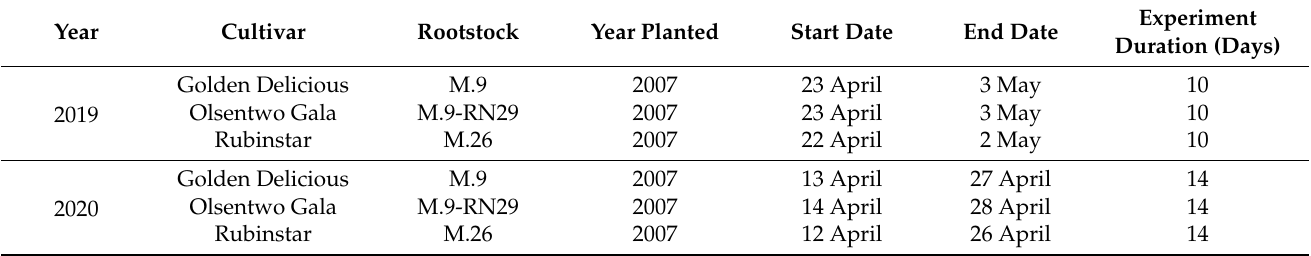
Table 4. Overview of the utilized cultivars, rootstocks, start and end dates of the effective pollination period (EPP) experiment in 2019 and